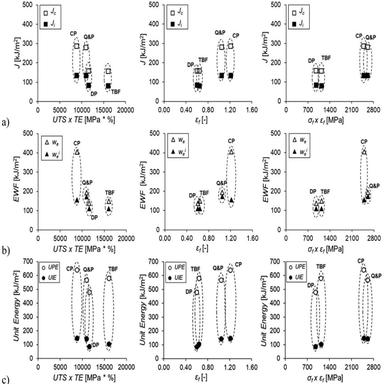
Fracture toughness as a function of: product of ultimate tensile strength (UTS) and total elongation (TE); true fracture strain (εf); product of fracture stress (σf) and true fracture strain (εf). (a) J-integral results, (b) EWF results and (c) Kahn-type tear tests results.